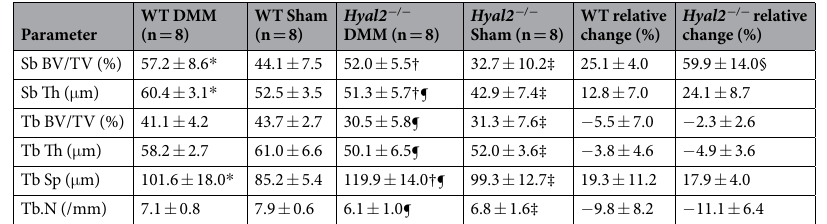
Table 1. Micro CT analysis at 10 weeks after DMM surgery. Relative increase of parameters was calculated as follows [(value of DMM – value of Sham) ÷ value of sham × 100%] * Statistically significant difference between Wild DMM and Wild Sham. †Statistically significant difference between Hyal2 − / − DMM and Hyal2 − / − Sham. ‡Statistically significant difference between Hyal2 − / − Sham and Wild Sham. §Statistically significant difference between relative increase Hyal2 − / − and Wild. ¶Statistically significant difference between Hyal2 − / − DMM and Wild